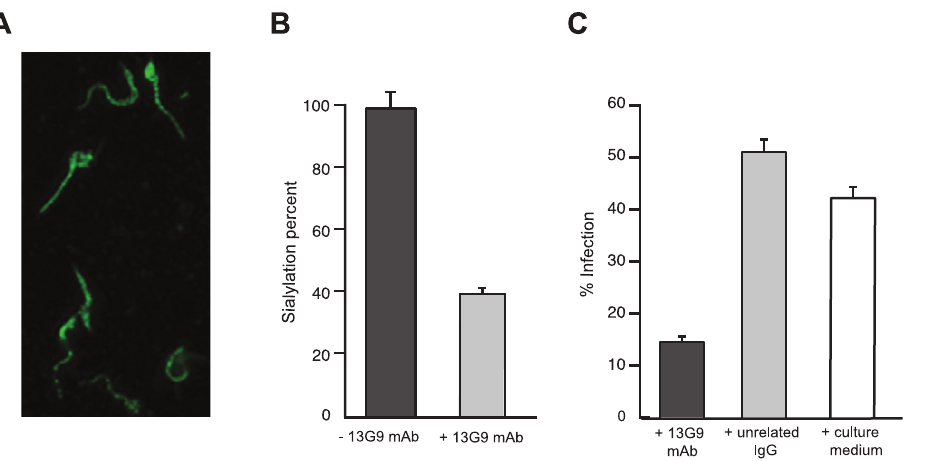
Figure 2. Reactivity of mAb 13G9 with T.cruzi parasites. A ) T. cruzi surface labeling by the 13G9 mAb. Epifluorescence microscopy of T. cruzi trypomastigotes, seeded onto poly-L-lysine-treated coverglasses, and immunolabeled with 13G9 mAb followed by a secondary FITC-labeled antibody. B ) Inhibition of parasite sialylation. Trypomastigotes obtained from cell cultures made in ‘low sialyl-donors’ conditions, were sialylated with TS and sialyllactose, in the presence of mAb 13G9. Total sialic acid was quantified by the thiobarbituric acid method and referred to re-sialylated parasites in the absence of mAb as 100% (approximately 1.2 pmoles of sialic acid/10 6 parasites). C ) Effect of mAb 13G9 in infection assays on mammalian cells. Parasites were preincubated for 1 h with 13G9 antibody (100 m g/ml) before infection. After 24 hrs, infected cultures were fixed and stained with Hoescht 33342. At least 300 cells were counted.